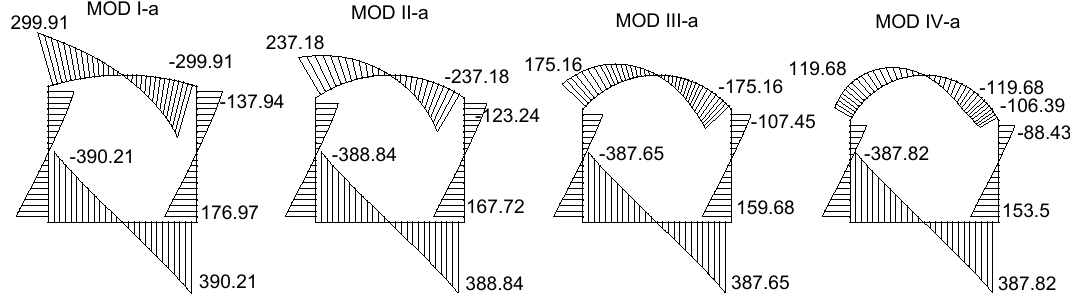
Figure 9. Diagrams of shear force (kN) for the modified culvert - Series a (H = 10m).